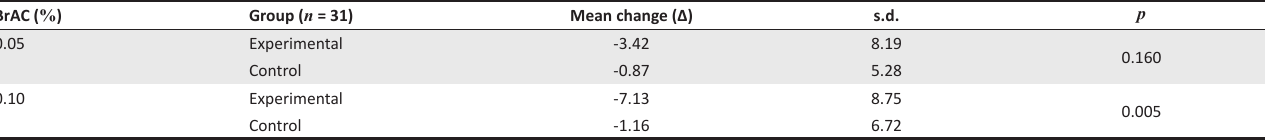
TABLE 4: Mean change for positive fusional vergence at near for blood respiratory alcohol concentration levels of 0.05 % and 0.10 % . BrAC ( % ) Group ( n = 31) Mean change (∆) s.d. p